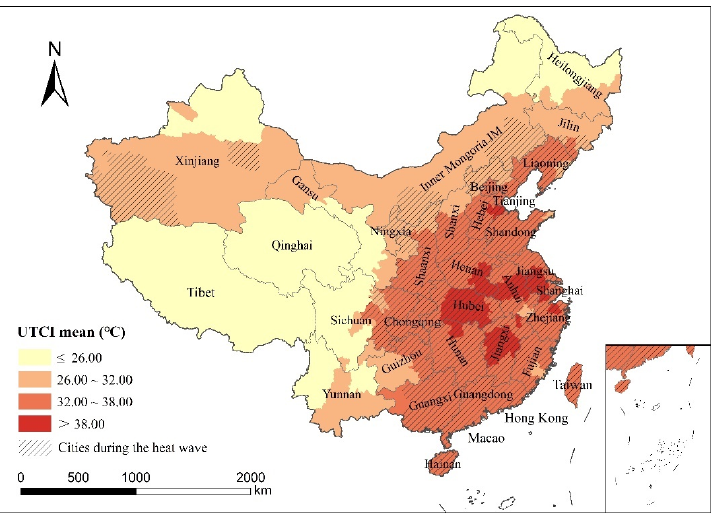
Figure 7. Mean UTCI distribution during the heat wave (shaded areas are cities during the heat wave). To avoid the influence of intraday or diurnal differences in UTCI values, the thermal comfort level with the highest frequency during the heat wave in each city was taken as the dominant thermal comfort level of the corresponding city, as shown in Figure 8. The regions with “very hot” thermal comfort were mainly located in the Beijing–Tianjin–Hebei region and the eastern part of Central China. Similar to the distribution of the UTCI mean value, the regions with a dominant thermal comfort grade of “hot” were also concentrated in East China. However, the distribution area with the dominant thermal comfort rating of “relatively hot” was smaller and more concentrated than the UTCI average. The domi- nant thermal comfort in a large area of Western China was “comfortable,” whereas the dominant thermal comfort in Northeast China was consistent with the UTCI average. Figure 9 shows the frequency spatial distribution of “extremely hot” and “hot/very hot/extremely hot” extreme thermal comfort levels in each city during heat waves. For the frequency of “hot/very hot/extremely hot,” the distribution of cities in China still showed a general trend of high in the southeast and low in the northwest, which is consistent with the distribution of UTCI mean and dominant comfort level. The Beijing–Tianjin–Hebei region and the middle and lower reaches of the Yangtze River were still highly distributed areas due to the influence of high temperatures caused by the subtropical high-pressure